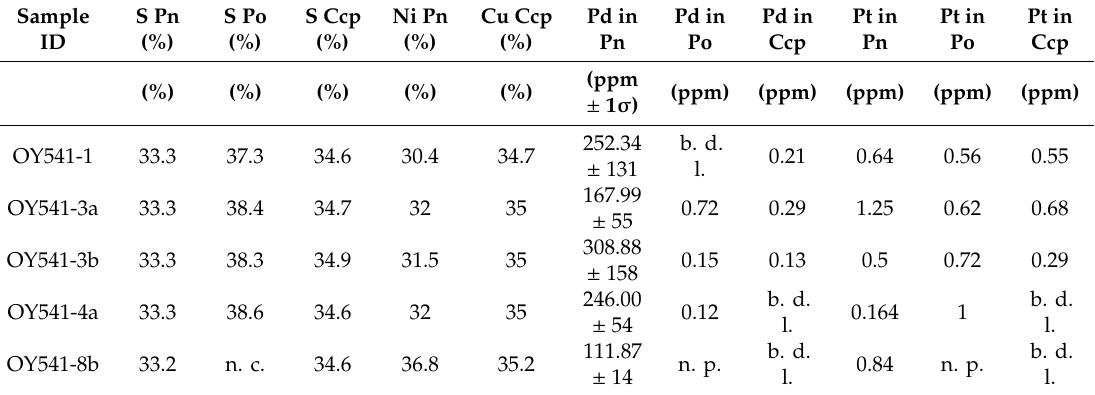
Table 6. Median values for S, Ni, and Cu (EMP), and Pd and Pt (LA-ICP-MS) in Pn, Po and Ccp, as a basis for the mass-balance calculation.